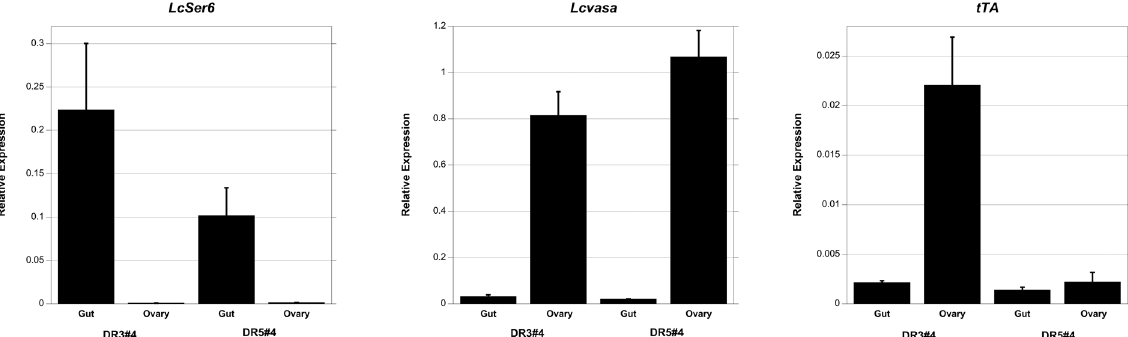
Figure 7. tTA expression in gut and ovary tissue from adult females. Relative expression of LcSer6 (left panel), Lcvasa (center panel), tTAv (DR3) and tTAo (DR5) (right panel) transcripts in total RNA isolated from adult female gut and ovary tissue dissected from DR3#4 and DR5#4 lines. Transcript levels were normalized to Lcalpha-tubulin . Mean relative expression + / − standard error from three biologically independent replicate qRT-PCR experiments are